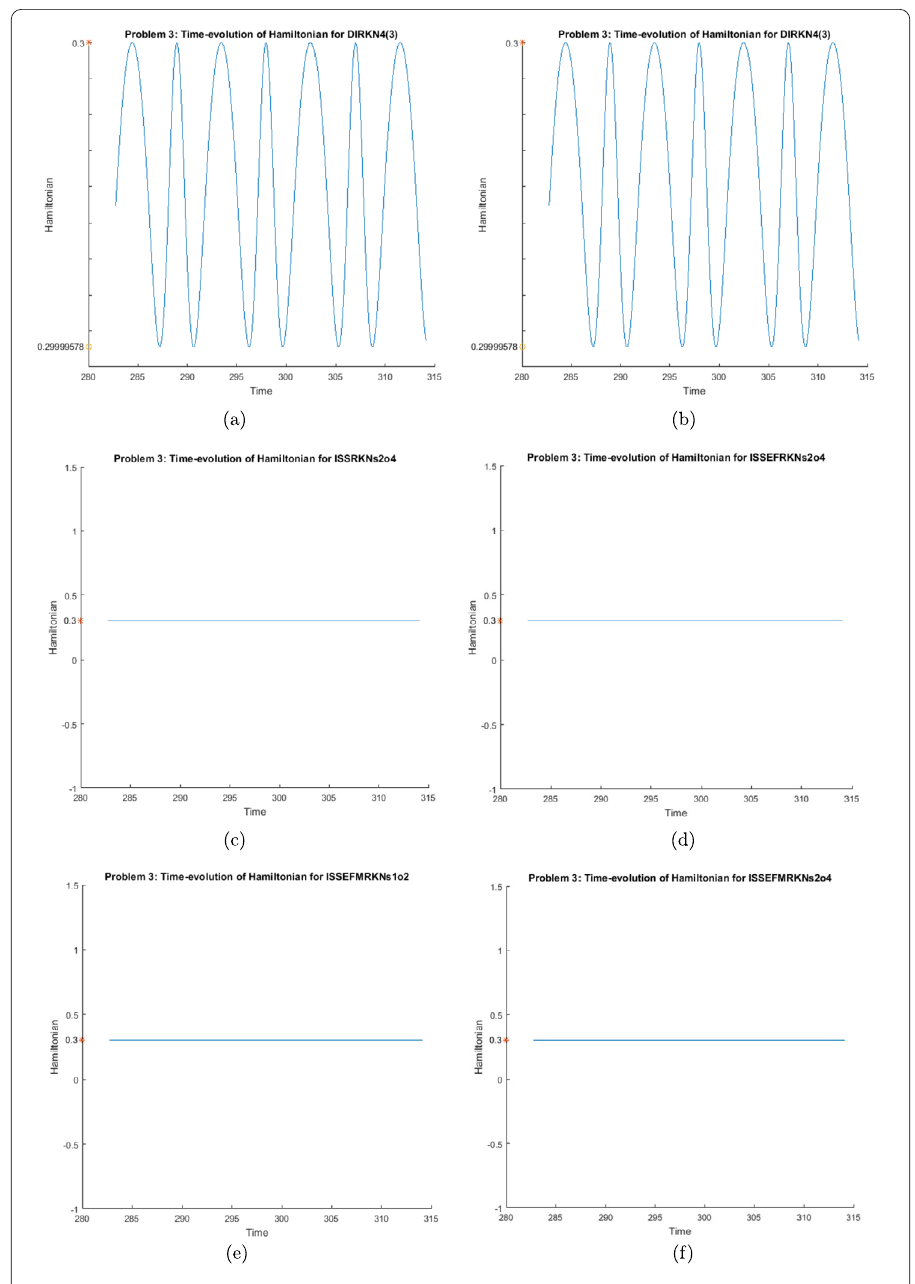
Figure 3 Numerical Hamiltonian for the methods ( a ) DIRKN4(3), ( b ) DIRKNs3o4, ( c ) ISSRKNs2o4, ( d ) ISSEFRKNs2o4, ( e ) ISSEFMRKNs1o2, and ( f ) ISSEFMRKNs2o4 in Problem